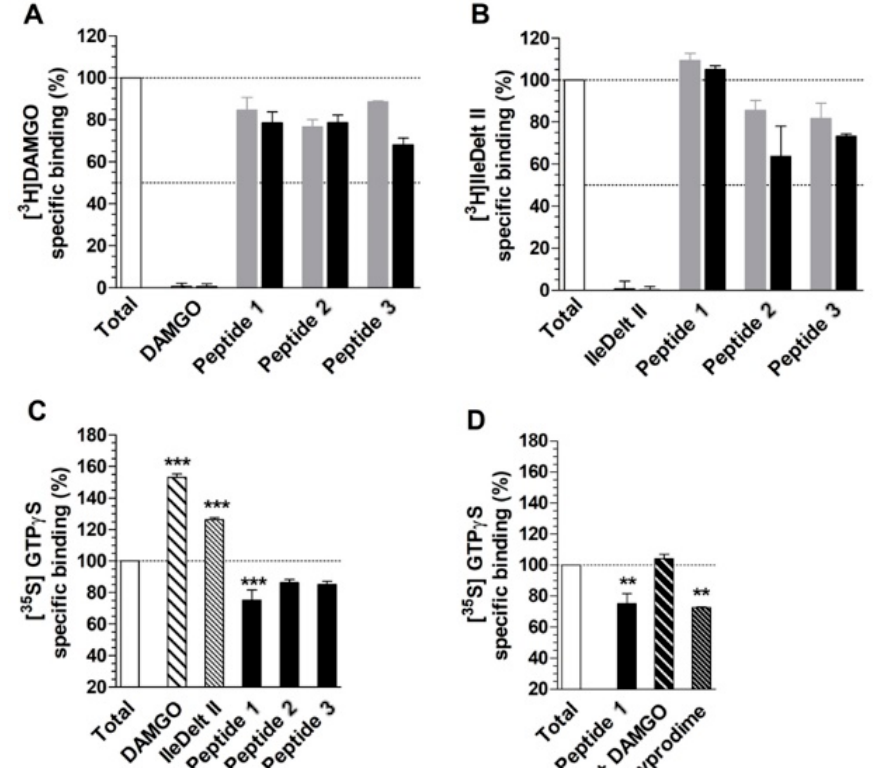
Figure 5. Competition binding (A and B) and G-protein activity (C and D) of peptides 1, 2 and 3. ( A ) and ( B) represent the specific binding of the indicated radioligands as a percentage, in presence of 3 (grey colored) and 10 µ M (black colored) of the indicated ligands. For control, the unlabeled homologous ligands of the radioligands are also indicated. ( C ) and ( D ) represent the specific binding of [ 35 S]GTP γ S as a percentage (mean ± S.E.M.), in presence of the indicated ligands at 10 µ M concentrations. ( D ) MOR specificity of peptide 1 in G-protein activity by displaying the [ 35 S]GTP γ S specific binding (mean ± S.E.M.) in the absence and presence of 10 µ M concentrations of DAMGO and cyprodime, MOR selective agonist and antagonist, respectively. In all cases “Total” represents the specific binding of the radioligand or [ 35 S]GTP γ S in the absence of the ligands. In the case of [ 35 S]GTP γ S, it also represents the basal activity of the monitored G-protein. The dotted lines indicate the level of total binding (100%) and 50% radioligand specific binding inhibition ( A and B ) or G-protein basal activity ( C and D ). ***: p > 0.001; **: p > 0.01. The experiments and data analysis were performed as described under section “[ 35 S]GTP γ S binding experiments” and “Data Analysis” within